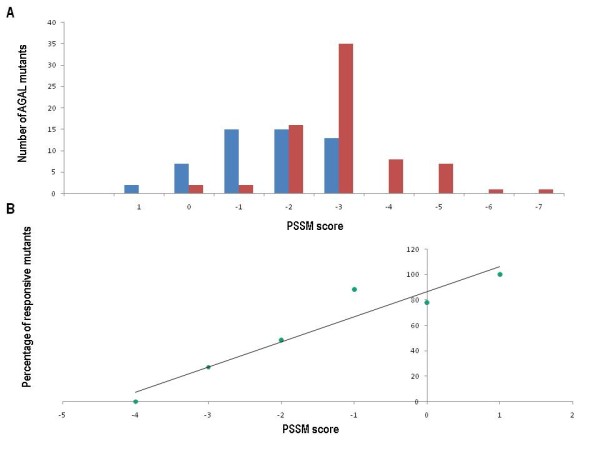
Distribution of responsive and non responsive alpha-galactosidase mutants and correlation of responsiveness with scores assigned with a Position Specific Substitution Matrix. Panel A: Distribution of responsive (blue bars) and non responsive (red bars) alpha galactodidase mutants over Position Specific Substitution Matrix scores. Panel B: Percentage of responsive alpha-galactosidase mutants as a function of Position Specific Substitution Matrix scores